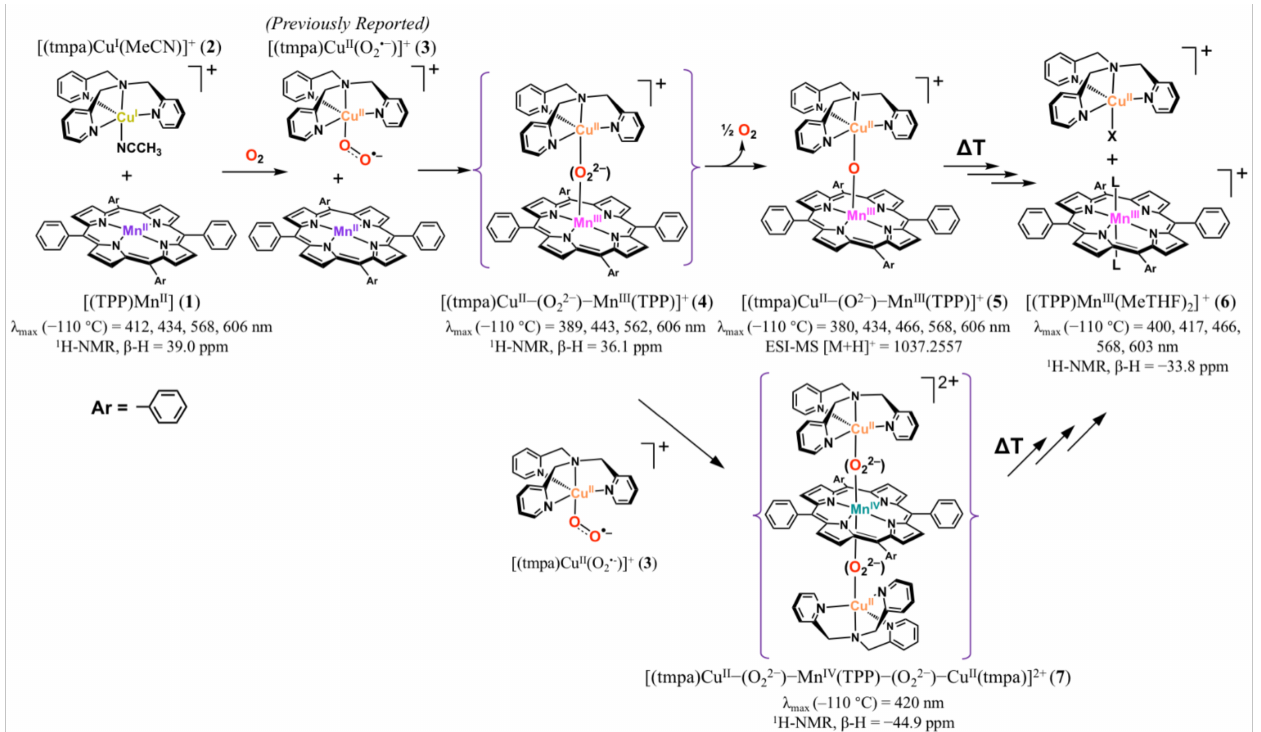
Scheme 1. Proposed reaction steps for the oxygenation of 1:1 and 1:2 mixtures of [(TPP)Mn II ] ( 1 )